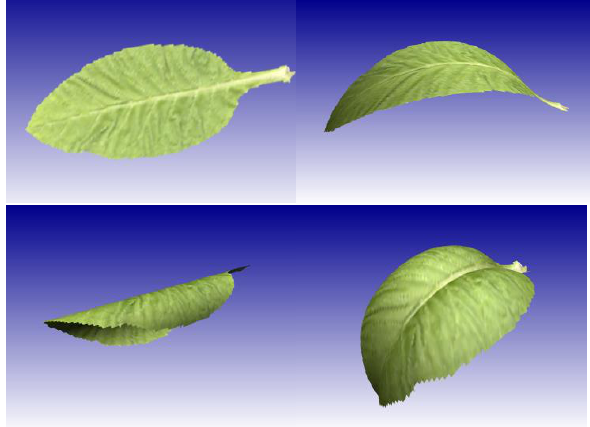
Figure 1. Generic leaf model: bending and